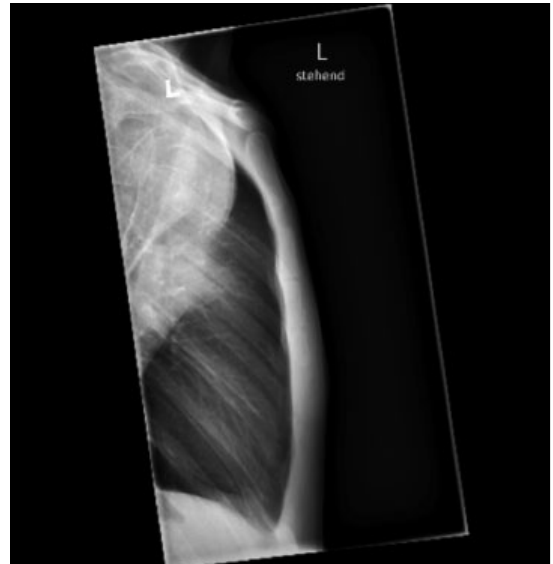
Fig. 3 Lateral chest X-ray without signs of fracture.